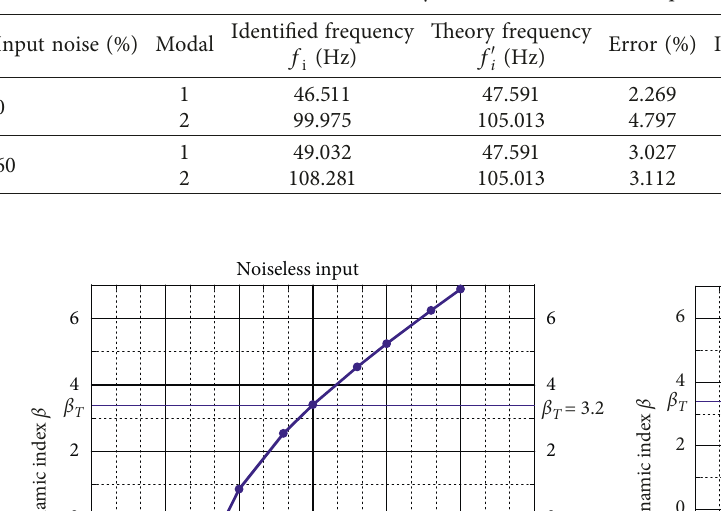
Table 3: The results for system of the identified frequencies and the theoretical